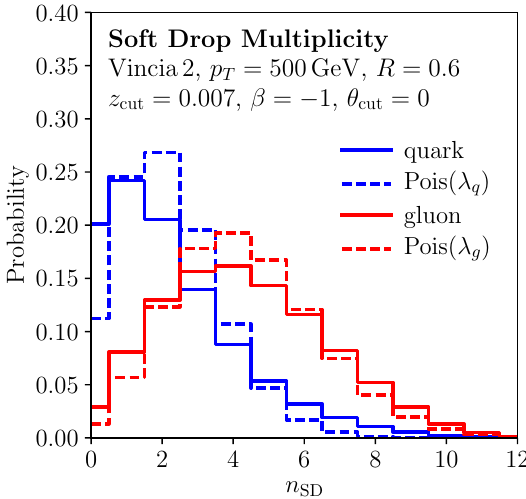
Vincia 2.0.01. Using the IRC-safe Figure 2. Distribution of the soft drop multiplicity n SD from benchmark parameters in eq. (2.7), we (cid:12)nd good quark/gluon discrimination power. For compari- son, we show Poisson distributions with the same means as dashed curves ( (cid:21) q = 2 : 2, (cid:21) g = 4 :